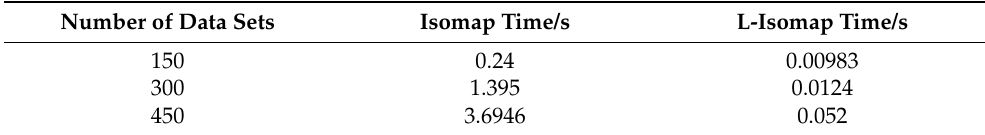
Table 7. Dimensionality reduction time comparison ( d = 7)/s.